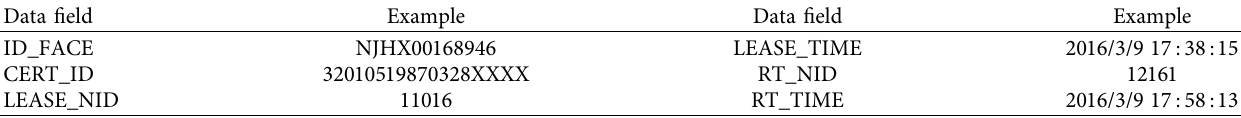
Table 1: Data fields and descriptions of bicycle-sharing user’s leasing and